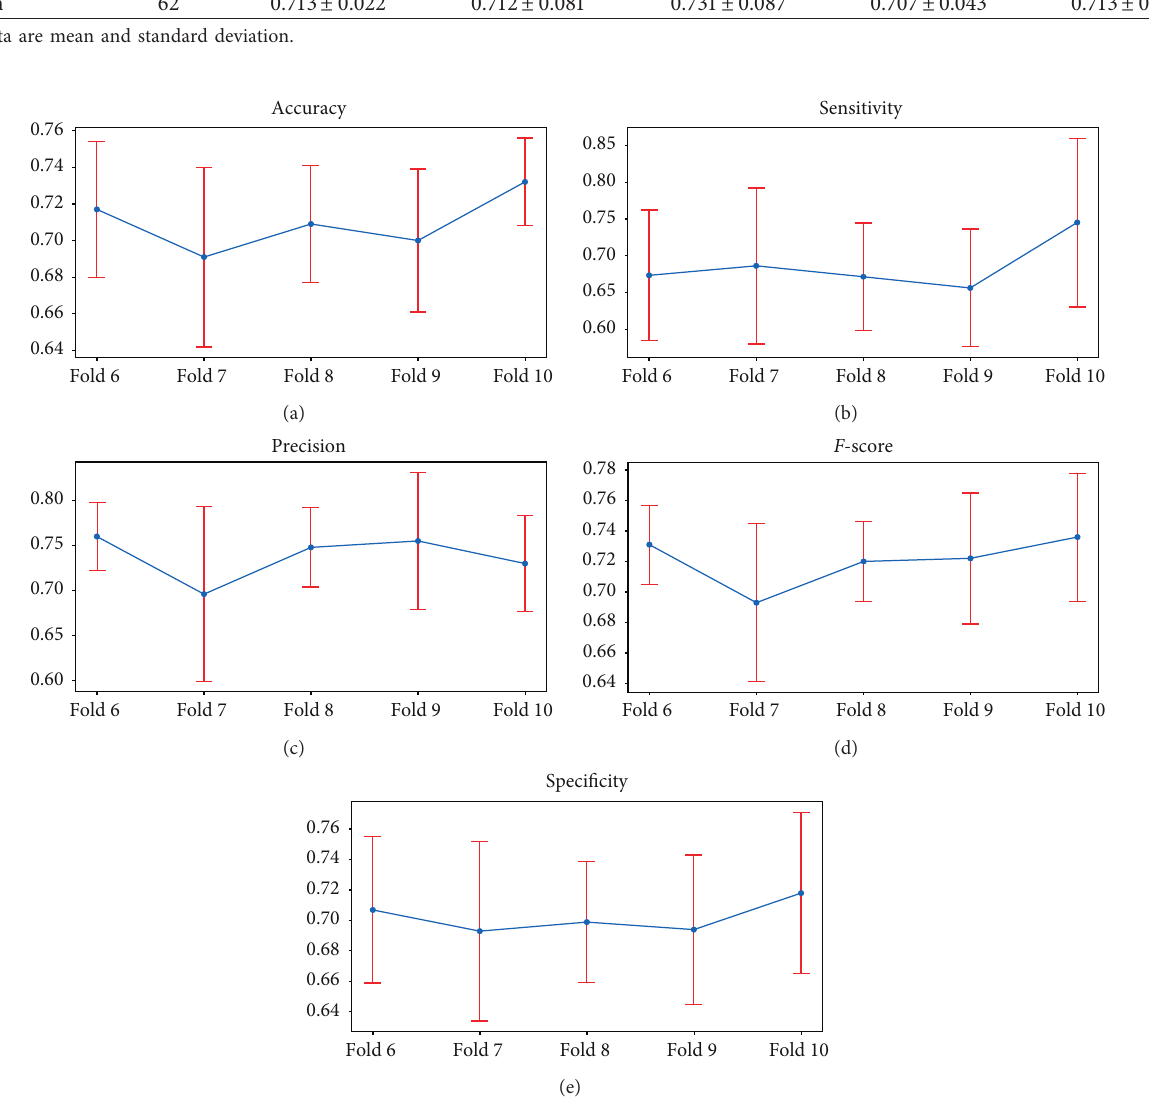
Figure 4: Performance of multichannel DANN over varying data split schemes with k -fold cross validation strategies ( k � [ 6 , 7 , 8 , 9 , 10 ]) . Mean and standard deviation are